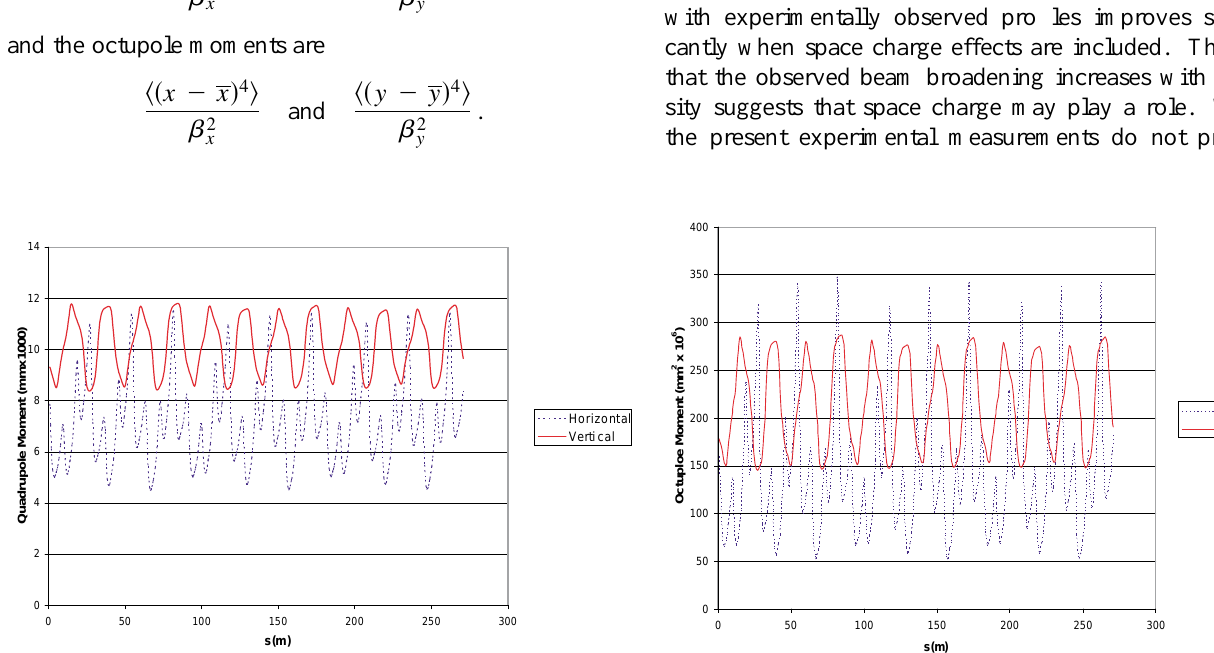
FIG. 7. (Color) Vertical and horizontal beam quadrupole and octupole moments versus longitudinal position over the last three turns, for the case with 3 3 10 13 injected particles, with a vertical bump, and with space charge. Longitudinal position s (cid:1) 0 m corresponds to the beginning of turn 2303, and position 270.8 m corresponds to the end of turn